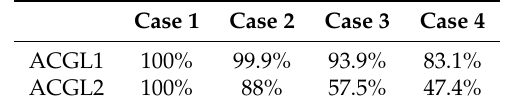
Table 3. Successful probability of two adaptive cooperative guidance laws (ACGL) with different measurement noise.